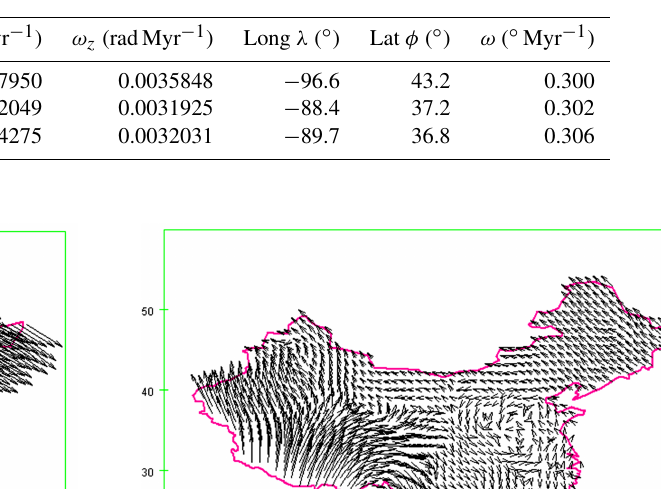
Figure 1. The velocity residuals statistics of 85 external checkpoints. The horizontal axes represent the horizontal velocity residuals (N: north; E: east; myr − 1 : meters per year) of a checkpoint. The vertical axes indicate the numbers of checkpoints (i.e., Point num) with corresponding residuals. Schemes 1–4 represent the models using Euler vector method, the collocation method, the multi-quadric function method, and the proposed multi-quadric collocation model. Table 3. Euler vectors of Chinese mainland.